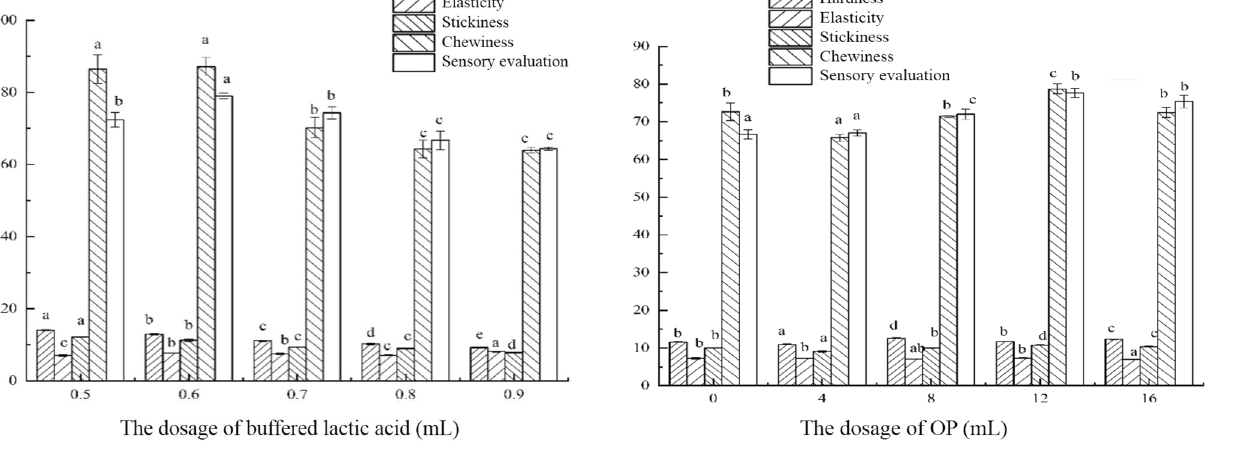
Fig. 2 Effect of buffered lactic acid dosage on the quality of gel gummies